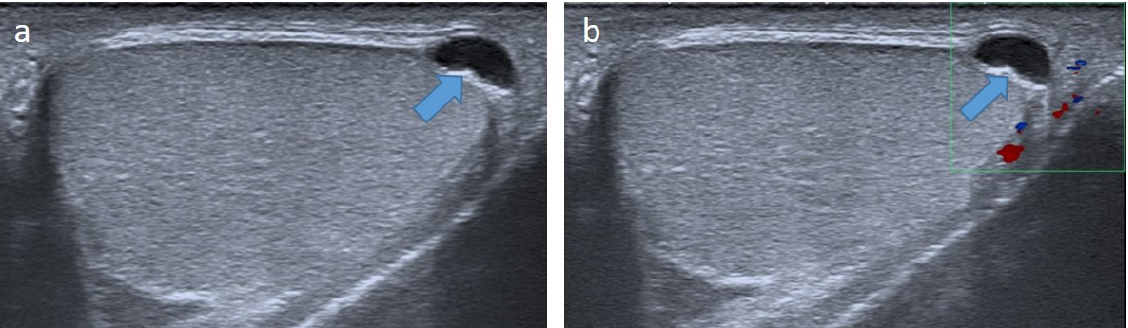
Figure 11. Para-testicular dermoid cyst in a 6-year-old boy. Longitudinal ( a ) gray-scale B-mode and transverse color Doppler ( b ) US of the scrotum. Images show an extra-testicular lesion (blue arrow) at the lower pole of the testis (star), demonstrating well-circumscribed margins, homogeneous echoic content with acoustic posterior reinforcement (arrow) without internal vessels on color Doppler images. Serum levels of tumor markers were normal, and the lesion was removed by an inguinal approach. US, ultrasonography.